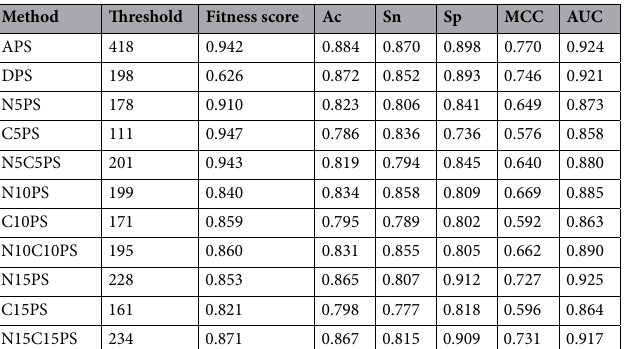
Table 3. Cross-validation results of FSCM models with various types of sequence features as evaluated on the alternative